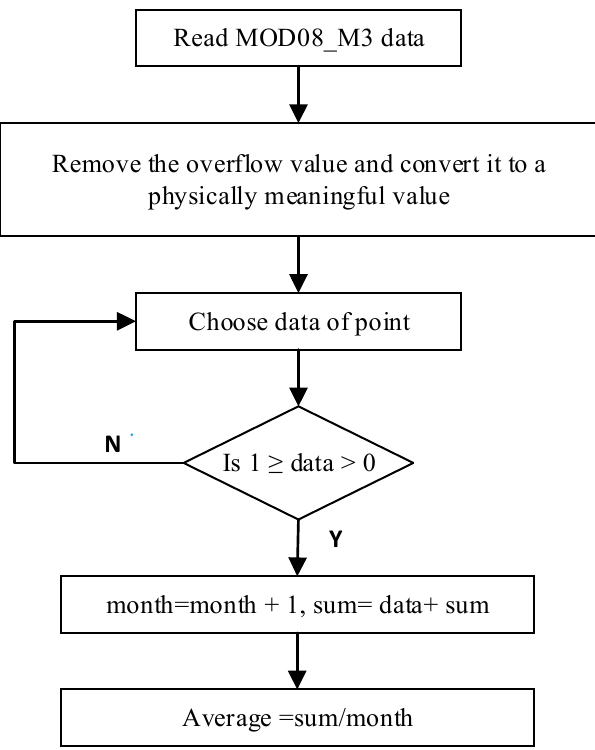
Figure 1. The flow chart of quality control for cirrus clouds data preprocesses: Obtain the effective samples. After quality control for cirrus clouds, the 12,784,191 effective samples are carried out. To eliminate the possible abnormal samples and increase the statistical significance, it is necessary to remove the possible abnormal values for the physical properties of cirrus clouds. The cloud top temperature is used as a final check, pixels with values less 267.5 K are set to ice. In our analysis, we use cloud top temperature in the MOD08 to get rid of the possible abnormal cirrus clouds samples. In order to study the global distribution of cirrus clouds, analysis is conducted on the fixed latitude levels. The latitude ranges, from 90° S to 90° N, are divided into 36 latitudinal grids with 5° interval. The latitude ranges of 80° N~90° N and 80° S~90° S are treated as the polar regions. No winter data are present because of polar nights in the polar region. Therefore, only the data of three seasons, i.e., spring, summer and autumn, are counted in the polar region. In statistics, the Pearson correlation coefficient (PCC), also referred to as Pearson’s R, is also used which is a measure of the linear correlation between two variables X and Y. According to the Cauchy-Schwarz inequality, it has a value between +1 and –1, where ±1 is total positive/negative linear correlation, 0 is no linear correlation [28]. 3. Global Cirrus Patterns 3.1. Global Distribution of Cirrus Reflectance The global distribution of the 18-year average cirrus reflectance is shown in Figure 2. It can be seen that the 18-year average cirrus reflectance in the Northern and Southern Hemisphere is not completely symmetrical. Overall, cirrus reflectance decreases firstly and then increases from the equator to 70°latitude. But for the same latitude zone in each Hemisphere, the variation of cirrus reflectance with longitude is different. For the mid-latitude region, the 18-year average cirrus reflectance varies obviously with longitude in the Northern Hemisphere, but varies gently with longitude in the Southern Hemisphere. Perhaps this phenomenon has related to modulation of land- sea distribution, the continental plate is larger in the Northern Hemisphere than the Southern Hemisphere except the polar circle. In the Northern Hemisphere, the land and sea are staggered at